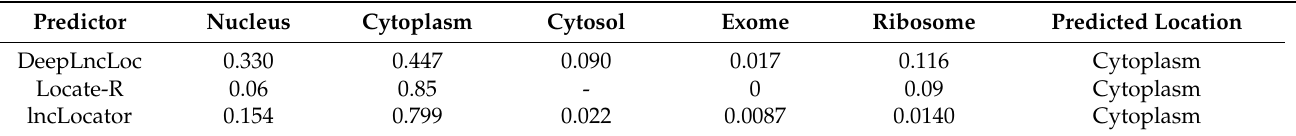
Table 3. Subcellular localization tools.